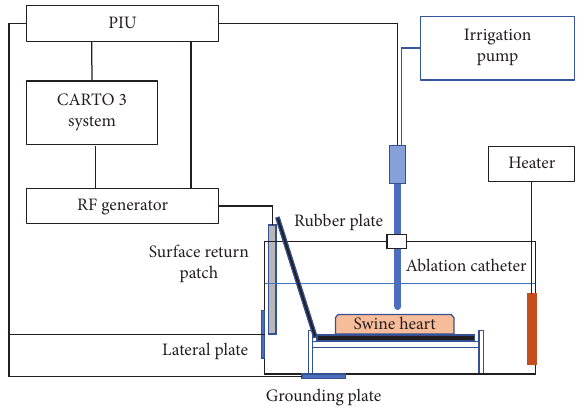
Figure 1: Schematic diagram of the in vitro ablation